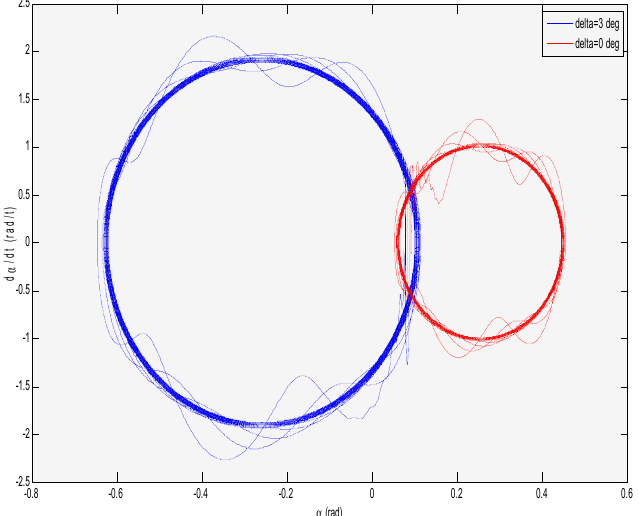
Figure 27. The state space response of alpha without freeplay and with 2 ◦ freeplay. (In flutter speed).